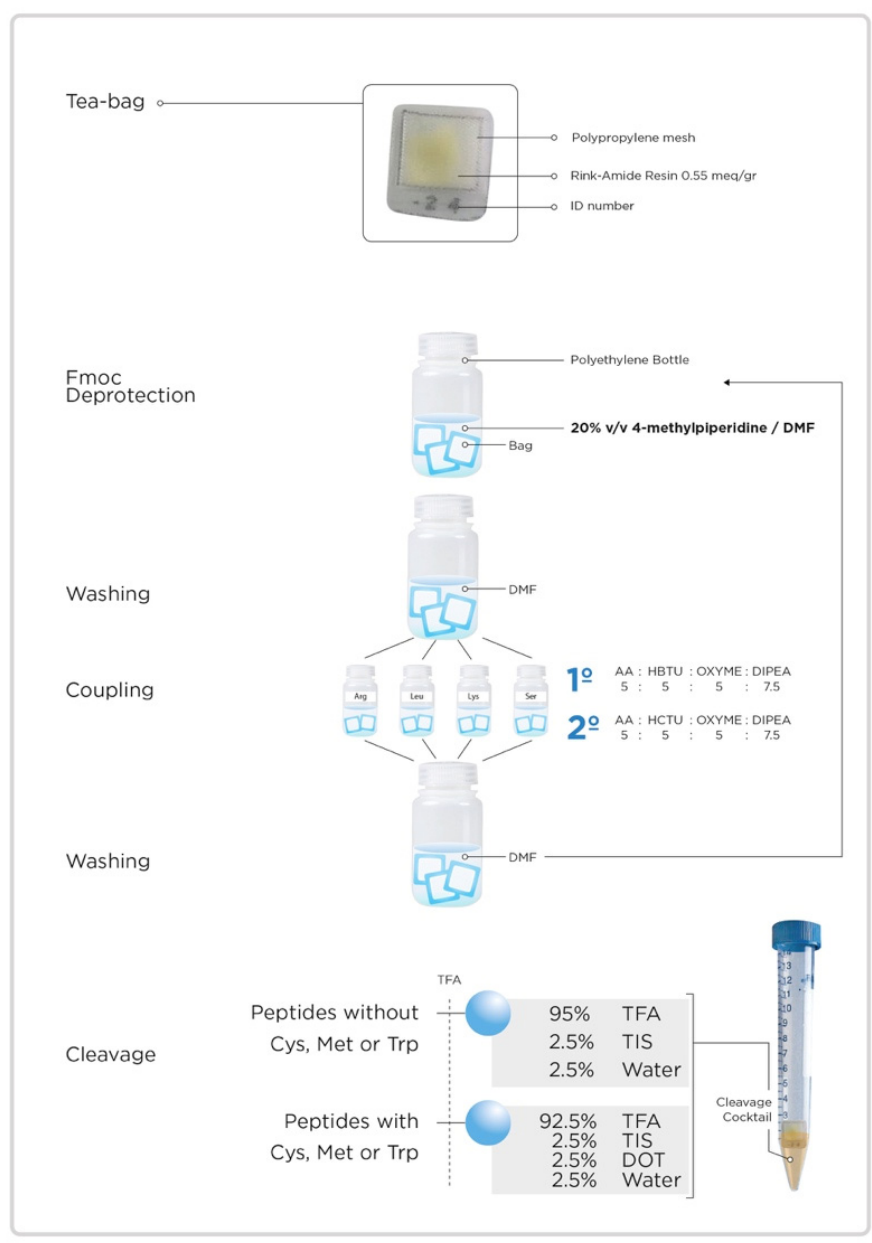
Figure 1. Schematic representation of the tea bag strategy for simultaneous solid-phase peptide synthesis.